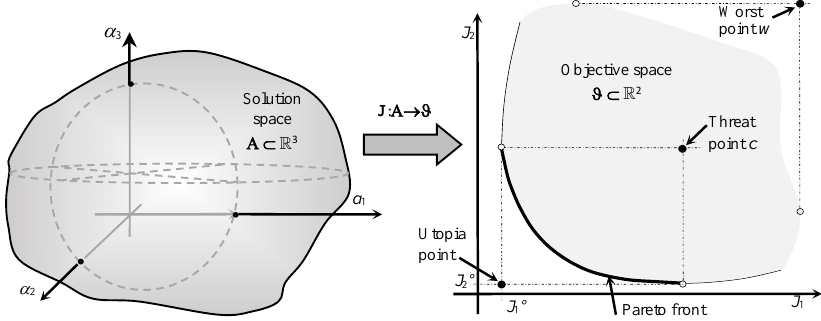
Figure 1. Schematic description of the multiobjective optimization problem.